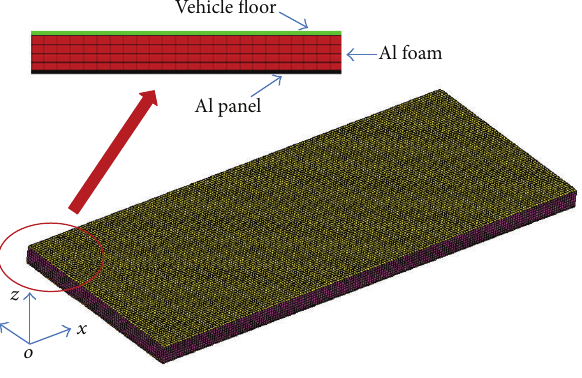
Figure 2: FE model of underbody armor plate for blast